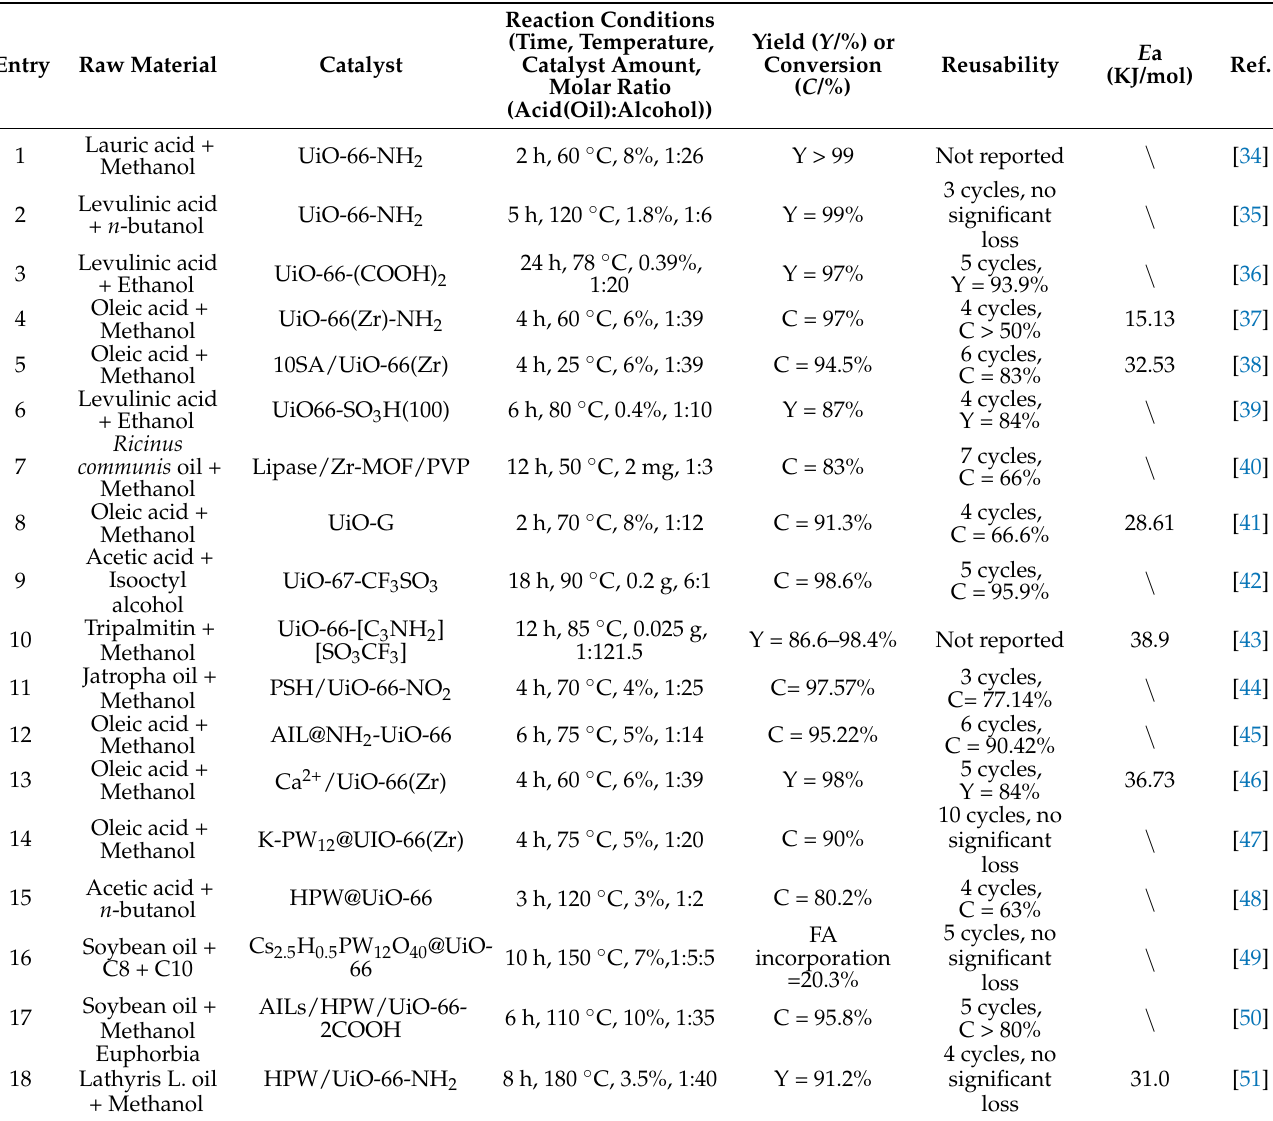
Table 1. Recent findings on green fuel production using modified Zr-based MOF